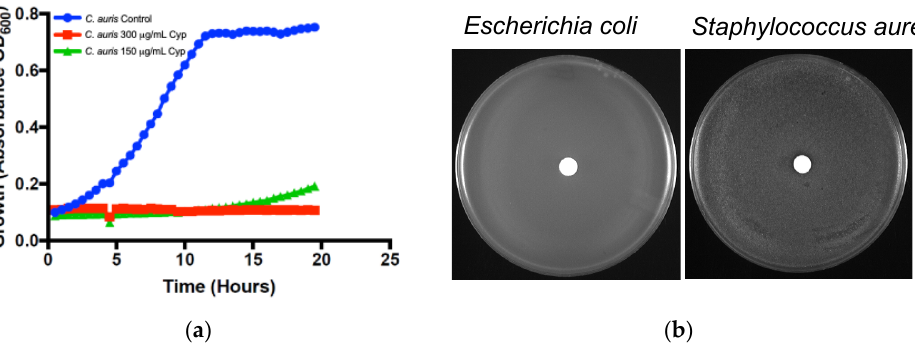
Figure 5. α -Cyperone affects drug-resistant C. auris , but has no effect on bacteria. ( a ) Inhibition of C. auris growth as determined by a growth monitoring system (Bioscreen-C). ( b ) Absence of antibacterial activity of α -Cyperone against E. coli and S. aureus. Sterile discs containing α -Cyperone (60 µ g/disc) was placed immediately after spreading the bacterial cell suspension (100 µ L, 10 9 /mL) on tryptic soy agar medium. Plates were incubated at 37 ◦ C for 24 h and photographed. Lack of inhibitory zones around the discs was